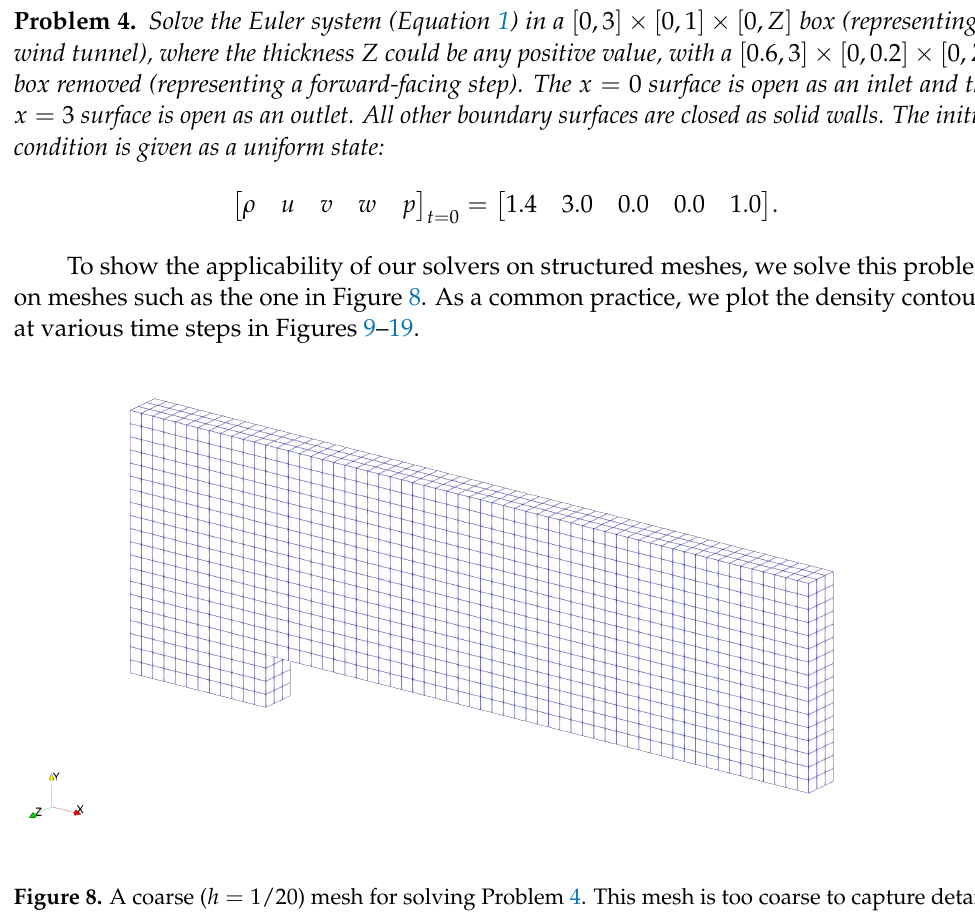
Figure 8. A coarse ( h = 1/20) mesh for solving Problem 4. This mesh is too coarse to capture details of the flow field but clear enough to demonstrate the distribution of nodes and cells. Actually, we use a much finer ( h = 1/200) mesh to produce Figures